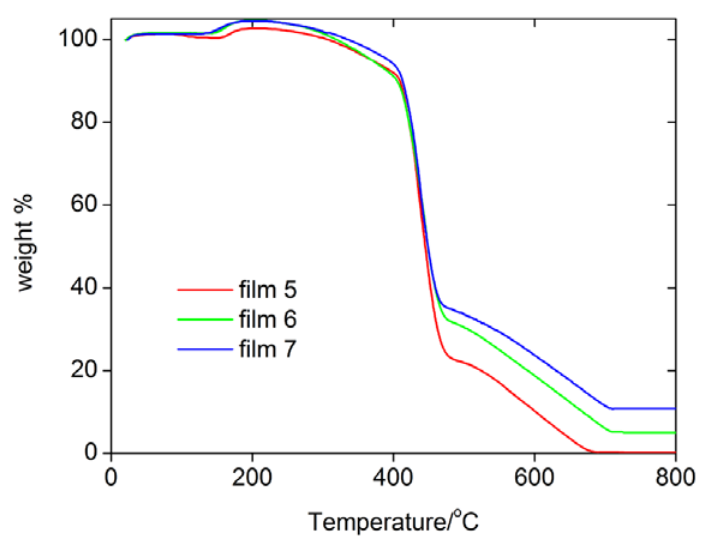
Figure 1 . TGA curves of some